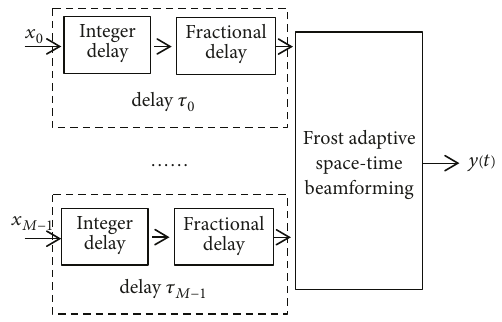
Figure 2: The scheme of the beamformer with a delay